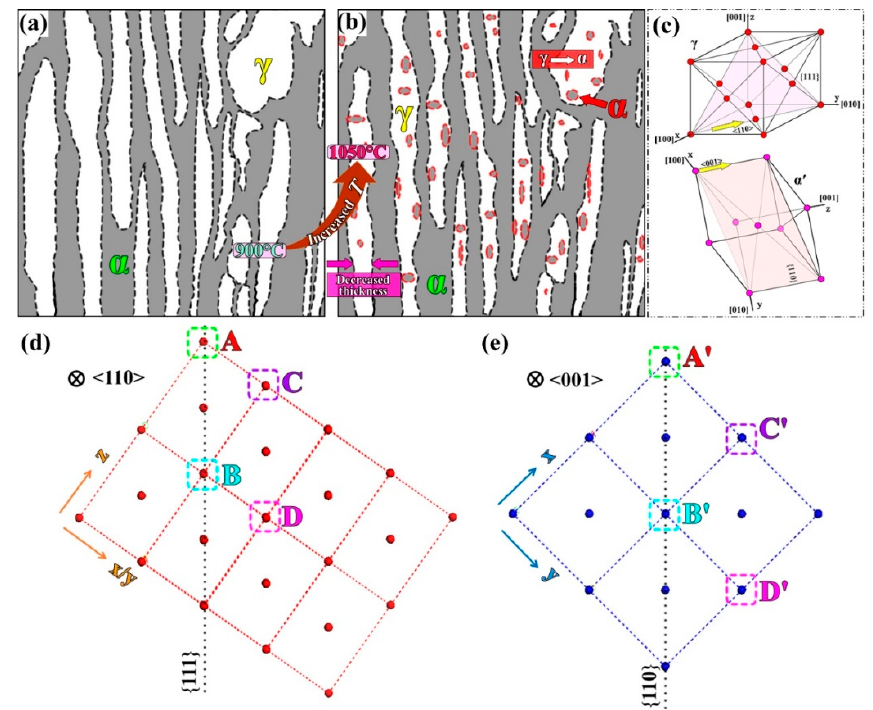
Figure 8. The schematic mechanisms of the phase transformation and orientation relationship between the γ and α′ -M phase, ( a ) banded duplex structure of α and γ , ( b ) decreased thickness of the banded γ phase and the appearance of α in γ phase, ( c ) unit cells of γ and α′ -M phase, ( d ) arrangement of atoms along <110> axis of γ , and ( e ) arrangement of atoms along <001> axis of α′ -M phase.